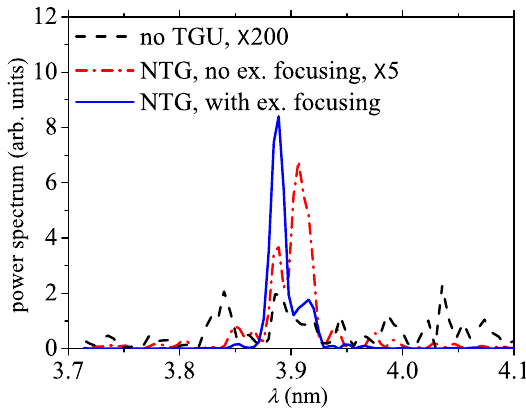
FIG. 7. The variation of the FEL power with the offset of the vertical beam orbit for using natural transverse gradient with external